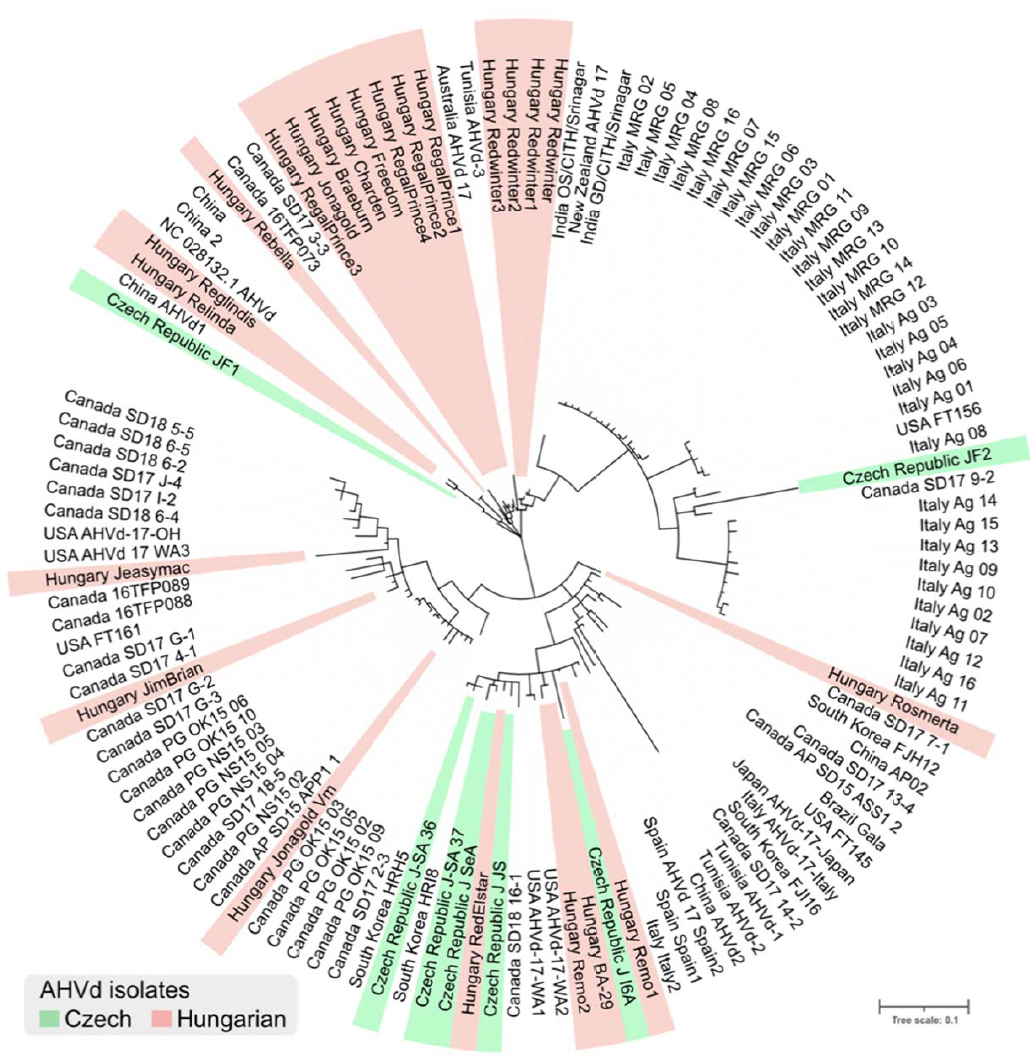
Figure 2. Phylogeny of AHVd isolates from the GenBank database and the current study. Czech and Hungarian isolates are highlighted. All branches with support less than 0.8 were